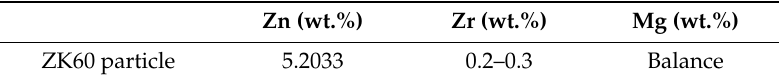
Table 1. The chemical composition of ZK60